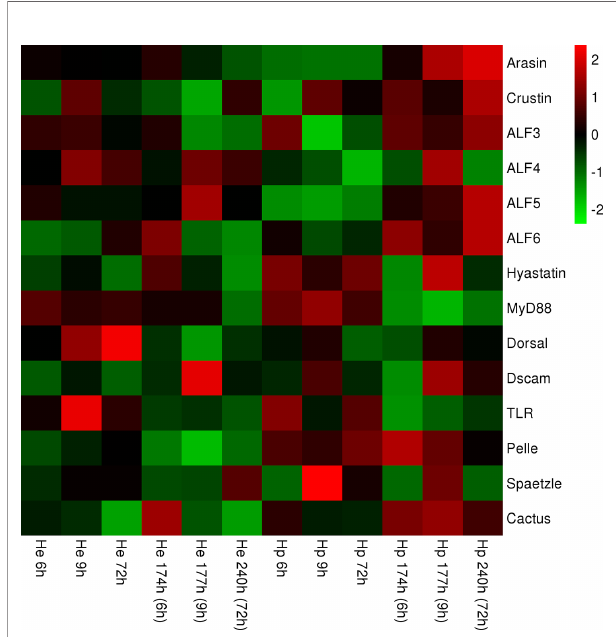
FIGURE 3 | Heat map representing expression of genes of members of the TLR signaling pathway and AMPs in hemocytes and the hepatopancreas, respectively, containing continuous time points [IPP (6, 9, and 72 h) and ICP (174, 177, and 240 h)]. The color scale at the far right of the heat map represents expression, whereby red, green, and black indicate upregulated, downregulated, and unaltered expression,